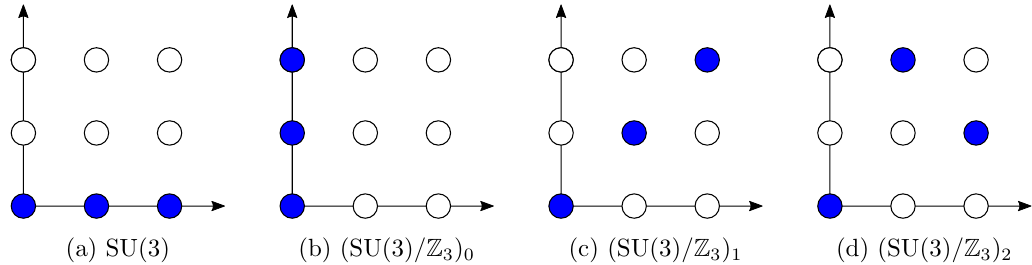
Figure 3. Maximal isotropic subspace of H 1 ( T 2 ; Z 3 ) = Z 3 (cid:8) Z 3 with respect to the perfect pairing (3.23). We have labelled the possibilities using the nomenclature of [18]. Each (cid:12)lled dot corresponds to a genuine line